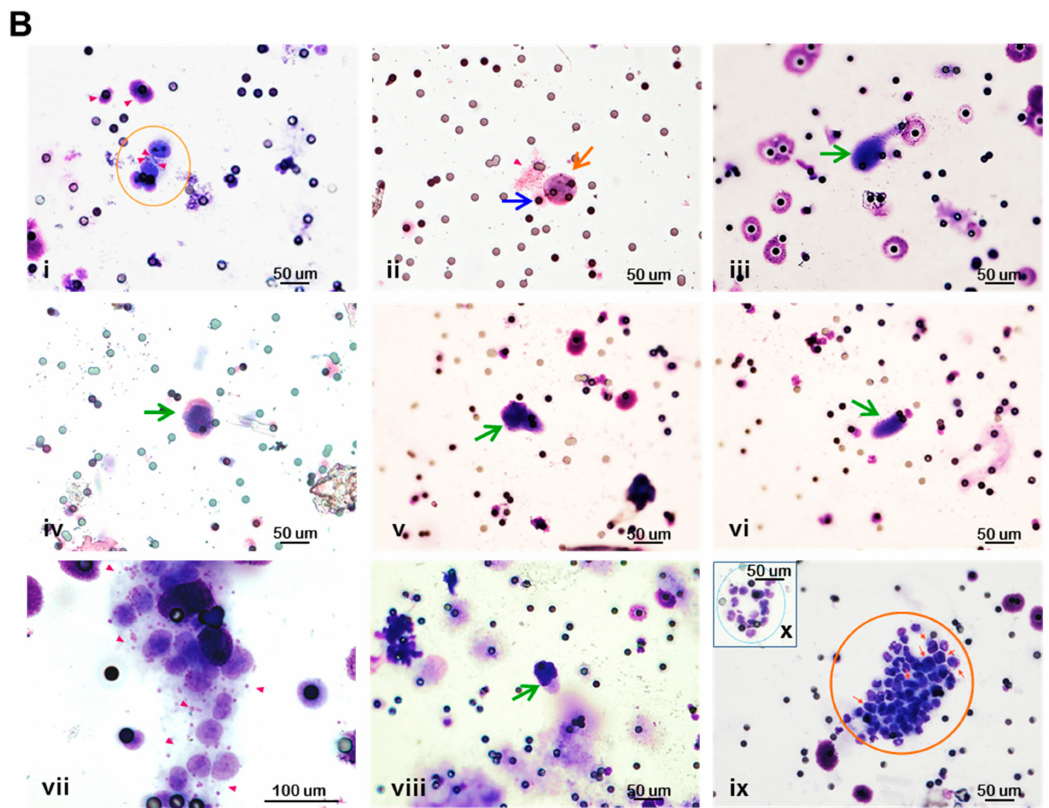
Figure 4. The morphological heterogeneity of CTCs and circulating host cells in BC xenograft models. ( A ) Images are representative of CTC pleomorphism: sCTCs (arrows) with di ff erent sizes from ( i ) BT-474 (40 × objective) and from ( ii ) MDA-MB-453 (60 × oil immersion); ( iii ) sCTCs (arrows) with low (top images) and high (bottom images) nucleus-to-cell ratios, and cCTC (circle) from MDA-MB-468 (40 × ); ( iv ) the cluster of two CTCs with multilobulated nucleus from MDA-MB-468 (60 × oil immersion); ( v ) cCTC from MDA-MB-231 (60 × oil immersion); ( vi ) sCTCs and CTCs in clusters (arrows) with di ff erent sizes from MDA-MB-231 (40 × ). ( B ) Images are representative of CTCs and circulating host cells: ( i ) a cluster of four CTCs (circle) and platelets (arrowheads) from BT-474 (40 × ); ( ii ) sCTC (orange arrow) in cluster with platelets (arrowhead) and one leukocyte (blue arrow) from MDA-MB-453 (40 × ); ( iii ) atypical giant cells cell from MDA-MB-453 (green arrow, 40 × ); ( iv , v , vi ) three atypical giant cells from MDA-MB-468 (green arrow, 40 × ); ( vii ) cCTC and platelets (arrowheads) from MDA-MB-231 (60 × oil immersion); ( viii ) an atypical giant cell from MDA-MB-231 (green arrow, 40 × ); ( ix ) a cluster (circle) of CTCs (arrows showing clearly distinguishable tumor cells) combined with leukocytes (40 ×